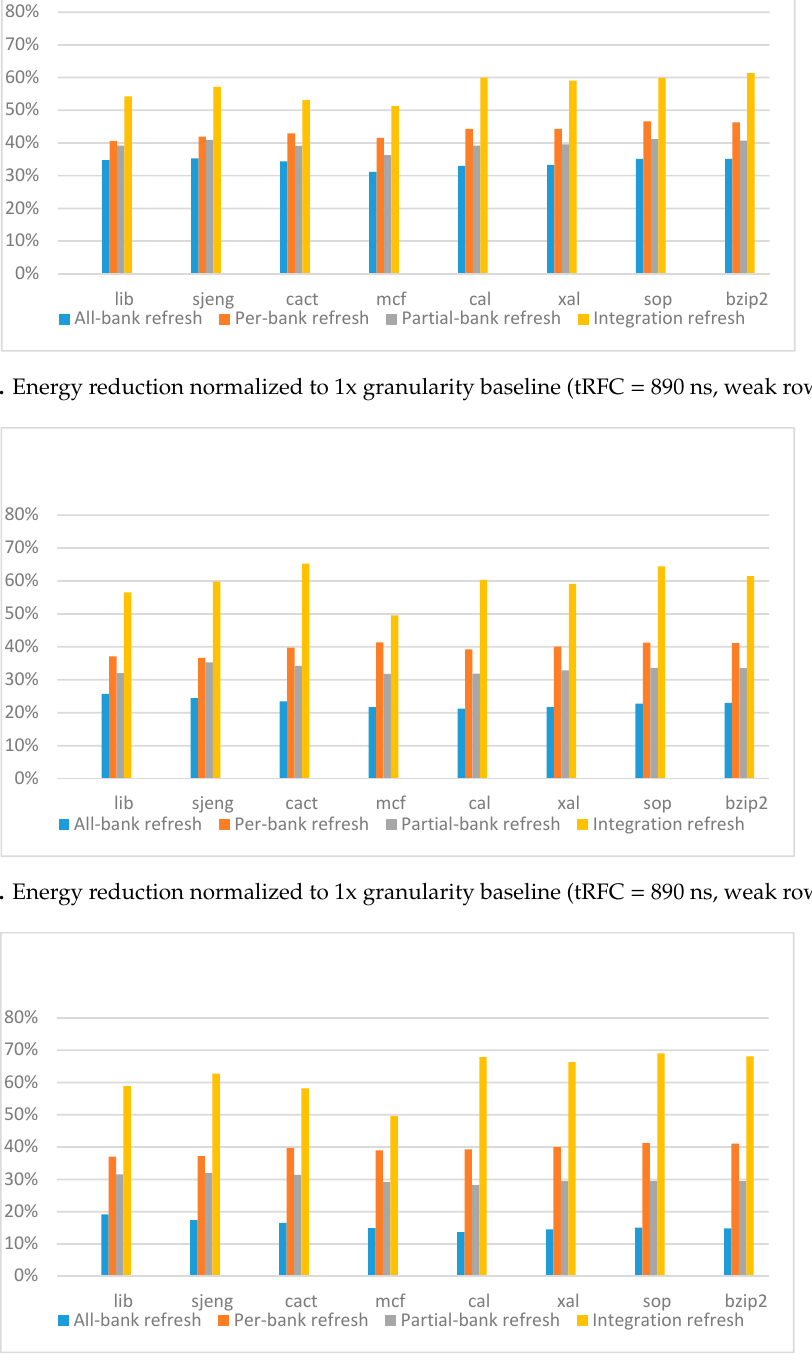
Figure 28. Energy reduction normalized to 1x granularity baseline (tRFC = 890 ns, weak row = 3%).